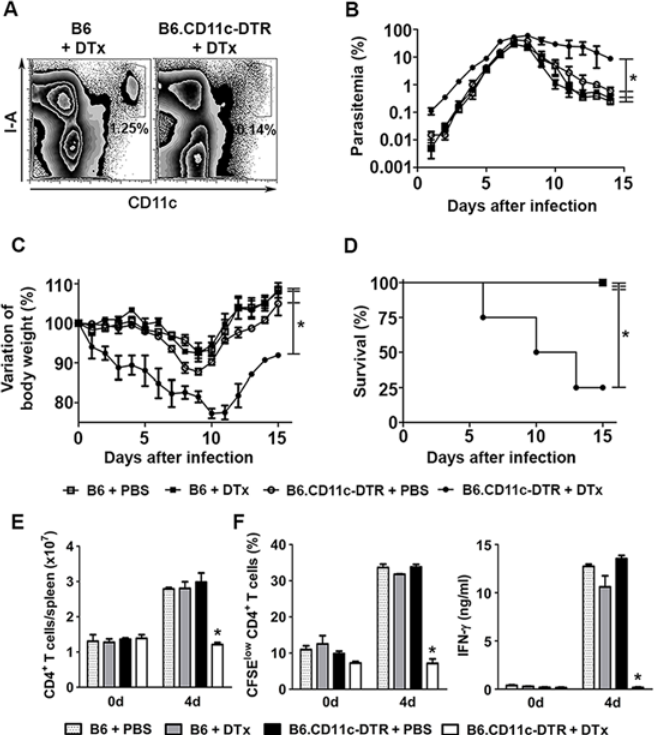
Figure 1. Effects of DC depletion on acute Pc malaria. (A-F) B6 and B6.CD11c-DTR mice were treated with either DTx to deplete CD11c + cells or PBS as a control. The mice were i.p. infected with 1 × 10 6 Pc iRBCs 24 h later. (A) Representative contour plots obtained 24 h after treatment by flow cytometry confirm the efficiency of DTx-induced depletion of splenic CD11c + I-A + cells in B6.CD11c-DTR mice. Data show the percentages of CD11c + I-A + cells in the splenocyte population. (B) Parasitemia curves are shown (means ± SD). (C) Variations in body weight relative to day 0 are shown (means ± SD). (D) Survival curves are shown. (E) Data show the numbers of CD3 + CD4 + T cells per spleen at days 0 and 4 p.i. (means ± SD). (F) Data show the percentages of proliferating CFSE low CD4 + T cells and IFN- γ concentrations in the supernatants of spleen cell cultures stimulated for 72 h with iRBCs (means ± SD). In B-D , significant differences (p < 0.05) between the indicated groups are designated by * . In E and F , significant differences (p < 0.05) between all other groups are designated by * . In A-F , one representative experiment out of three (n = 5) is shown.